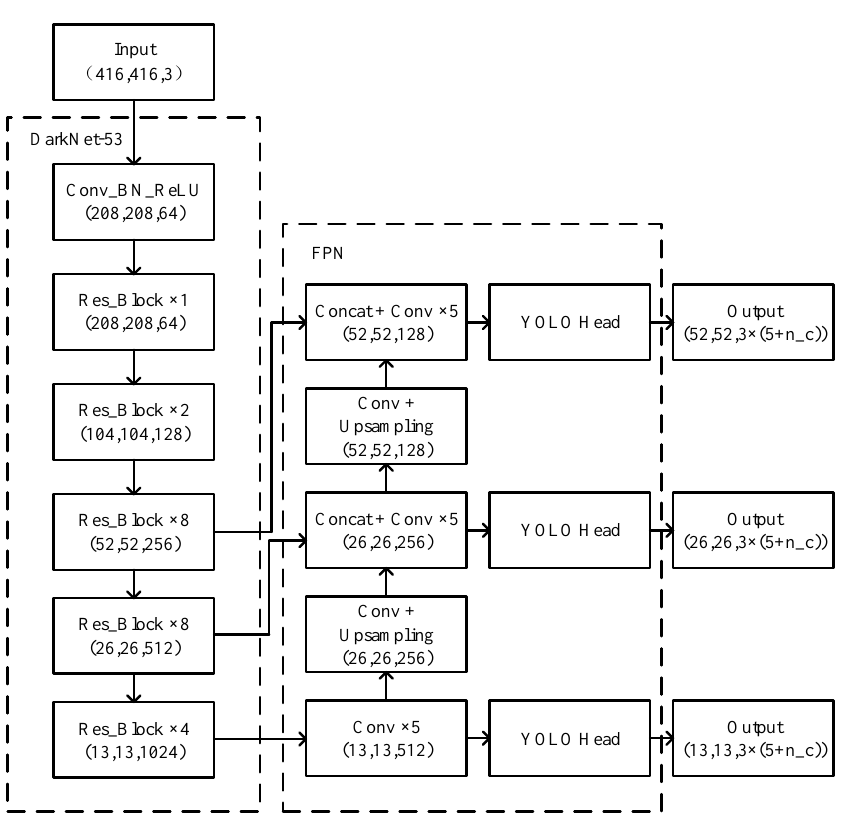
Figure 3. The network structure of